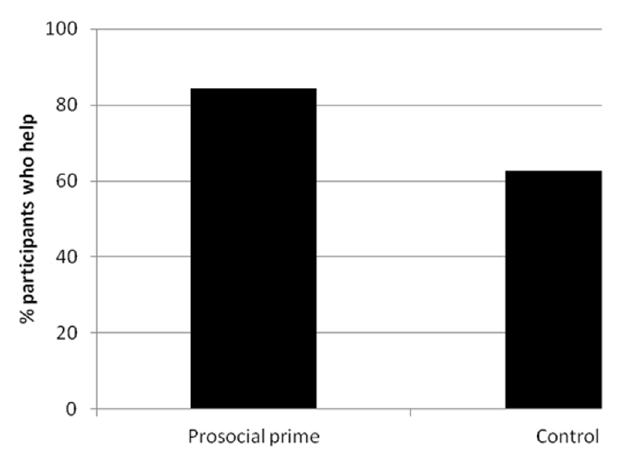
Figure 1. Participants who helped in control and prosocial prime